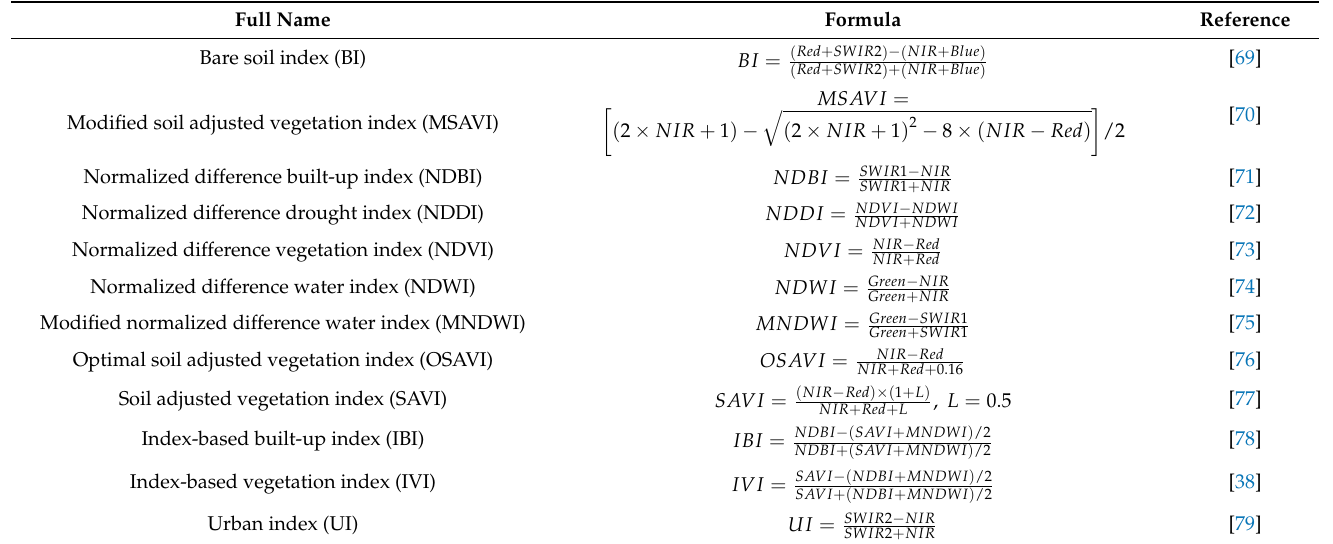
Table 2. Information of the remote sensing spectral